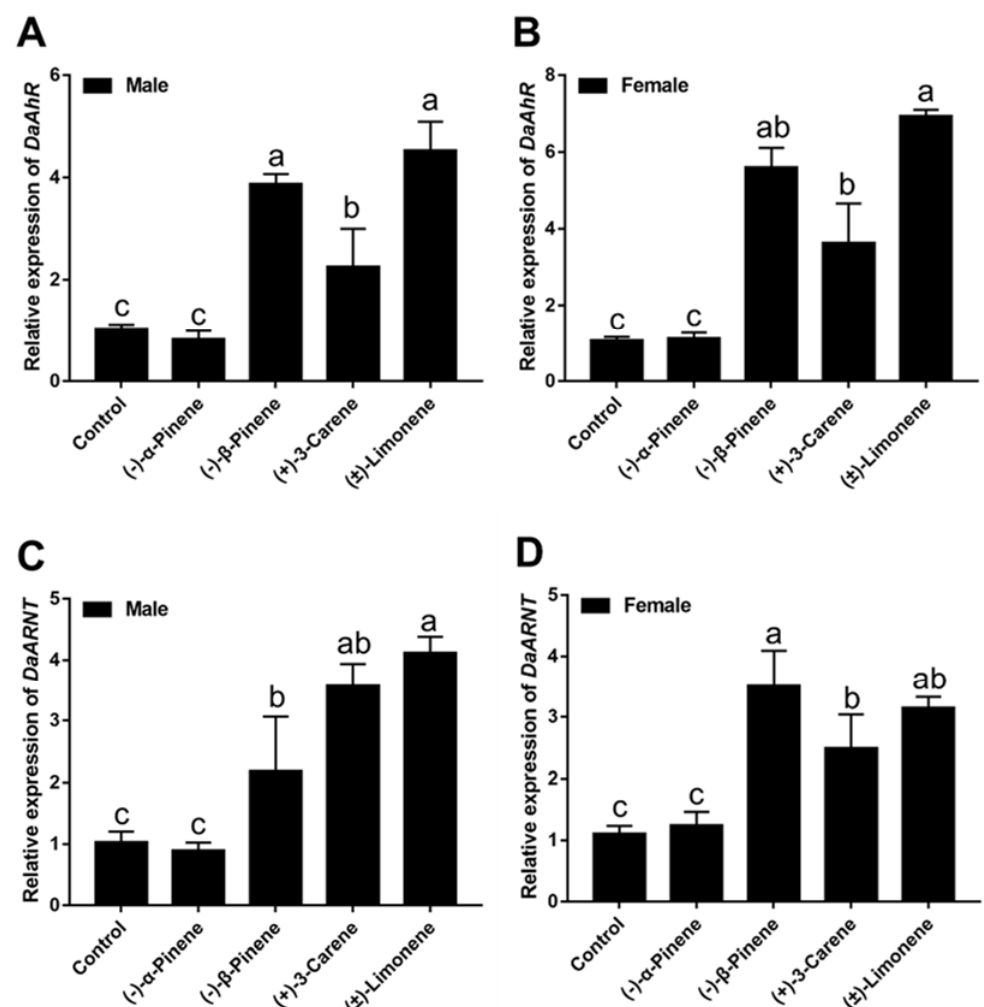
Figure 4. Relative expression levels of AhR and ARNT in male adults ( A , C ) and female adults ( B , D ) of D. armandi after stimulation with four terpenoids at an exposure time of 48 h. The relative expression levels were normalized with β -actin and CYP4G55 . Different letters indicate significant differences at p < 0.05. Post-hoc Tukey tests following one-way analysis of variance (ANOVA). All values are mean ± SE , n = 3.